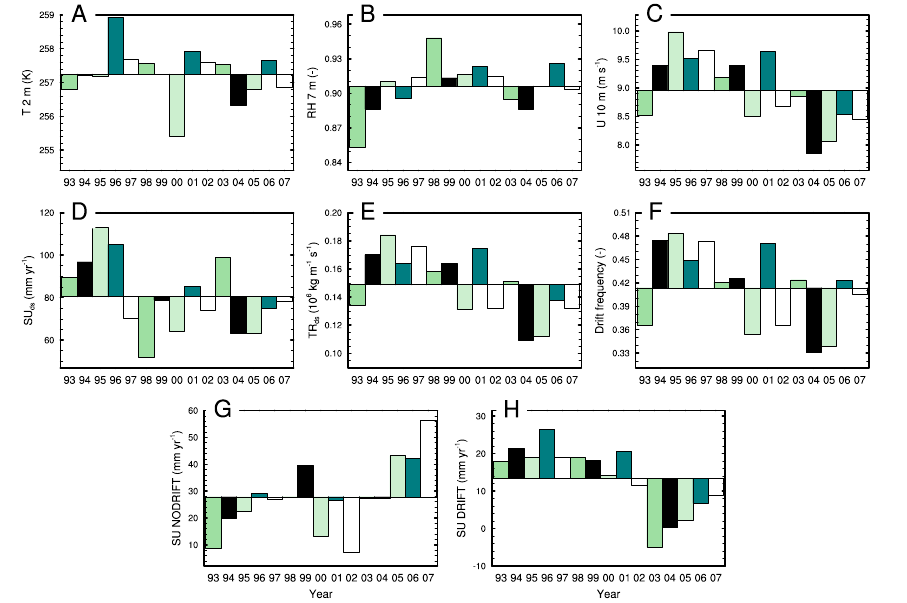
Fig. 10. Annual means (1993–2007) of 2m temperature (A) , 7m relative humidity (B) , 10m wind speed (C) , snowdrift horizontal trans- port (E) and snowdrift frequency (F) , combined with the cumulative amounts of snowdrift sublimation (D) and surface sublimation in the case without snowdrift (G) and with snowdrift (H) , respectively. All variables are shown relative to their 10yr mean